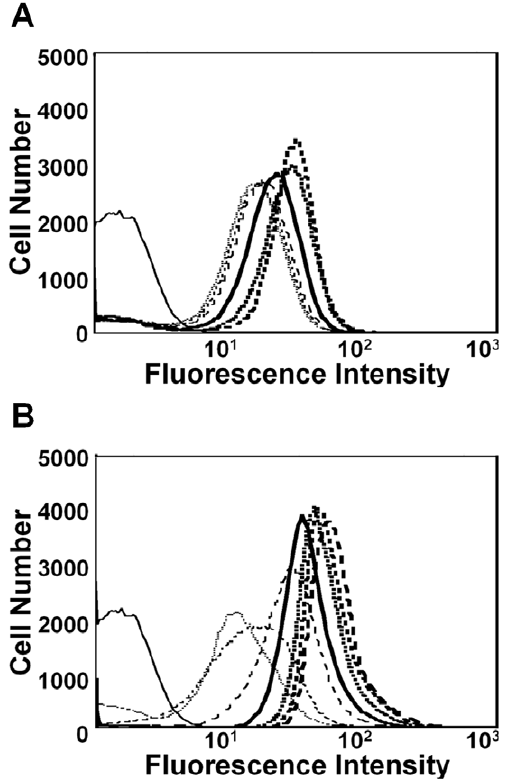
Figure 5. Histograms showing the number of cells with a given fluorescence in E.coli MG1655 cultures harboring pPro7(E)- gfp and JM1013. Cultures of (A) the MG1655 harboring pPro7(E)- gfp and (B) the JM1012 harboring the 3 plasmids (pPL-PCB, pCph8, and pJM1/ pJM2) were analyzed. E. coli harboring pET28a empty vector was used as a control. Cell cultivation was performed as described in Materials and Methods. The fluorescence in single cells was measured after induction of 6 h with different propionate concentrations or light exposure times. Propionate concentrations: control (solid line), 0 mM (dot line), 0.2 mM (dashed line), 0.8 mM (long-dashed line), 3.2 mM (bold solid line), 12.6 mM (bold dotted line), and 50 mM (bold dashed line). Light exposure times: control (solid line), 0 h (dotted line), 1 h (dashed line), 2 h (long-dashed line), 3 h (bold solid line), 4 h (bold dotted line), 5 h (bold dashed line), and 6 h (bold long-dashed line).